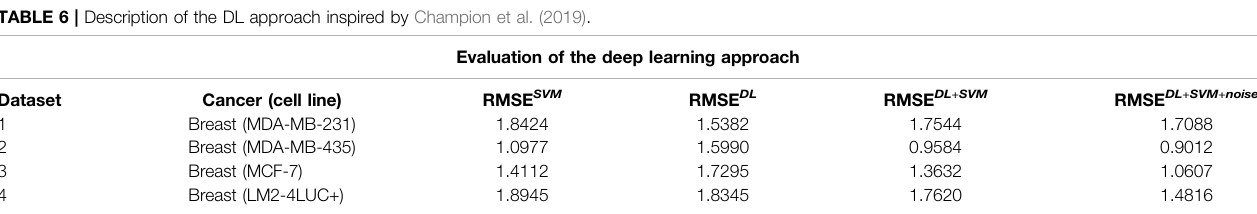
TABLE 6 | Description of the DL approach inspired by Champion et al.